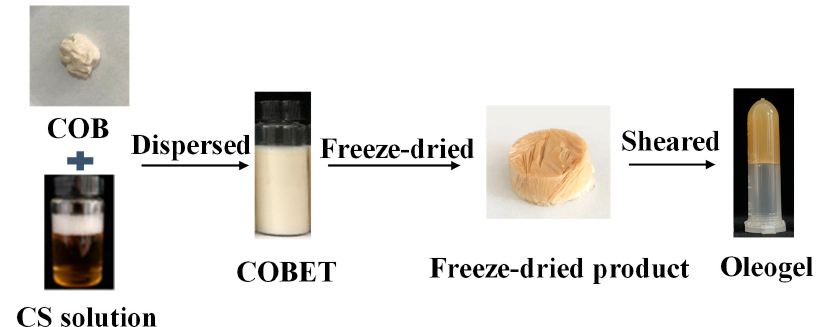
Figure 1. The process flow diagram for producing oleogels using COBET.